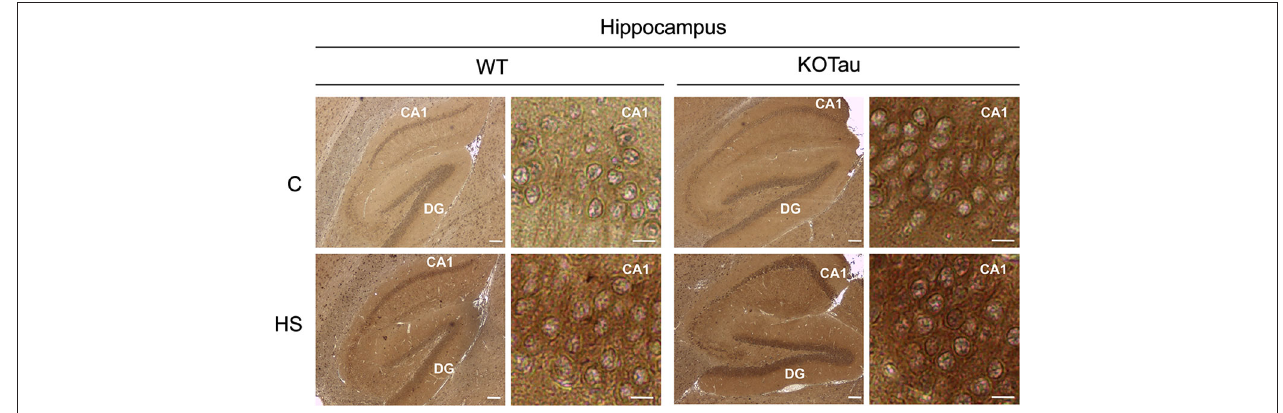
(DNPH) in sagittal sections of the hippocampus from WT and KO-Tau mice under control (C) or heat stress (HS) conditions. HS increased DNPH staining in WT and KO-Tau sections. Scale bars indicate 200 or 10 µ m